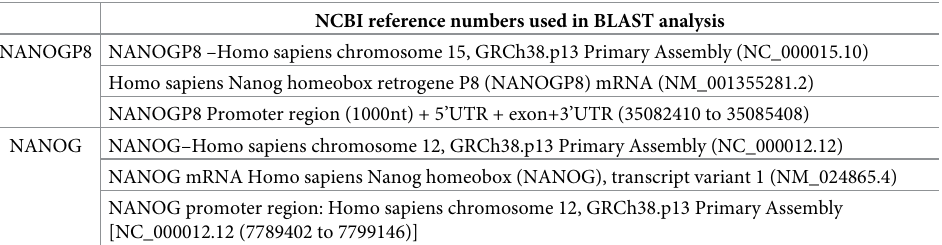
Table 1. NCBI GENBANK reference numbers for NANOGP8 and NANOG sequences used during BLAST analysis. NCBI reference numbers used in BLAST